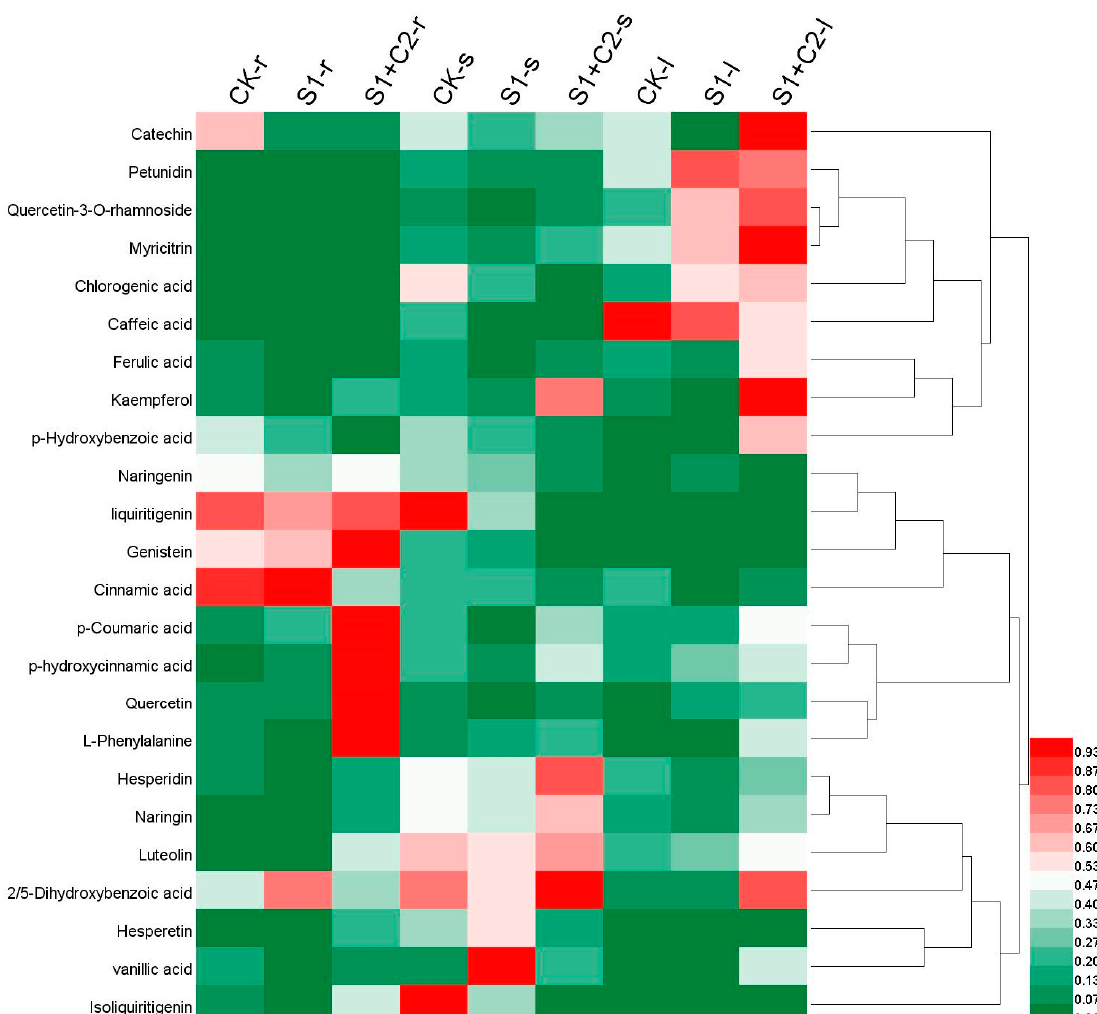
Figure 6. Heat map visualization of phenolics in different treatment of G. sinensis . The color range from red to green indicates relative abundance from high to low (color key scale right the heat map). r: root; s: stem; l: leaf.